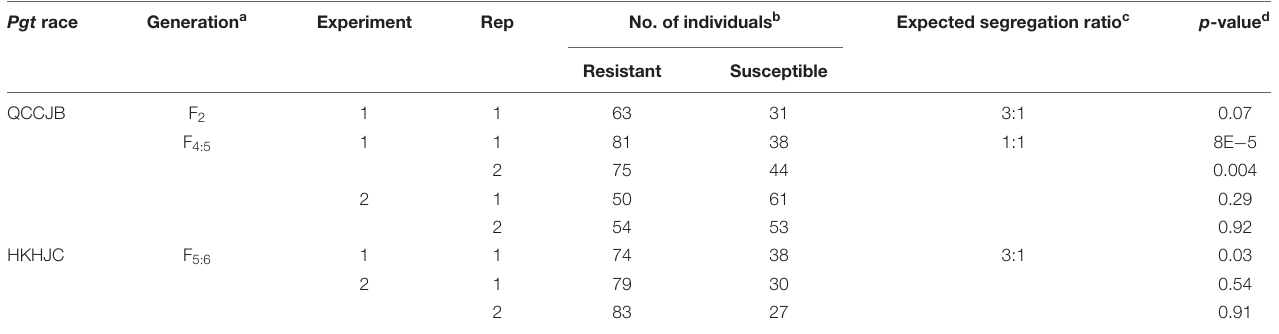
TABLE 1 | Chi-square goodness-of-fit test to assess the segregation for resistance to susceptibility in different generation of progenies generated from Pinnacle RMRL-NIL/Q21861. Pgt race